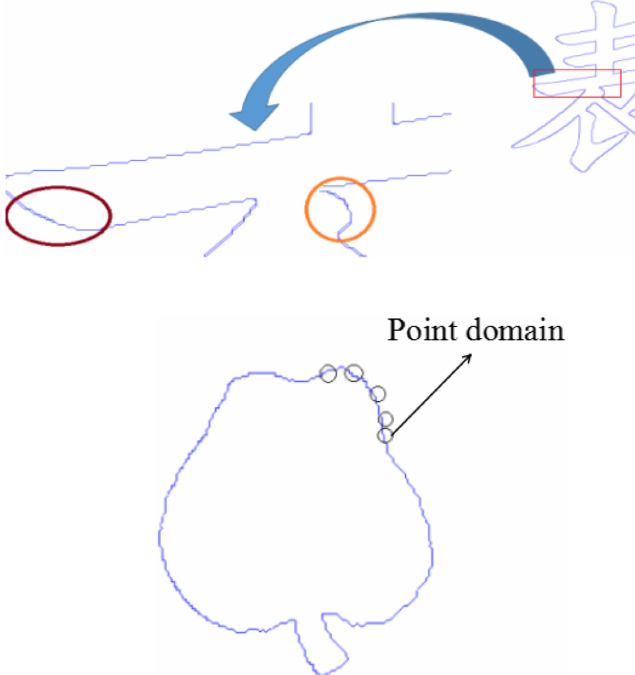
Figure 6. Near-point